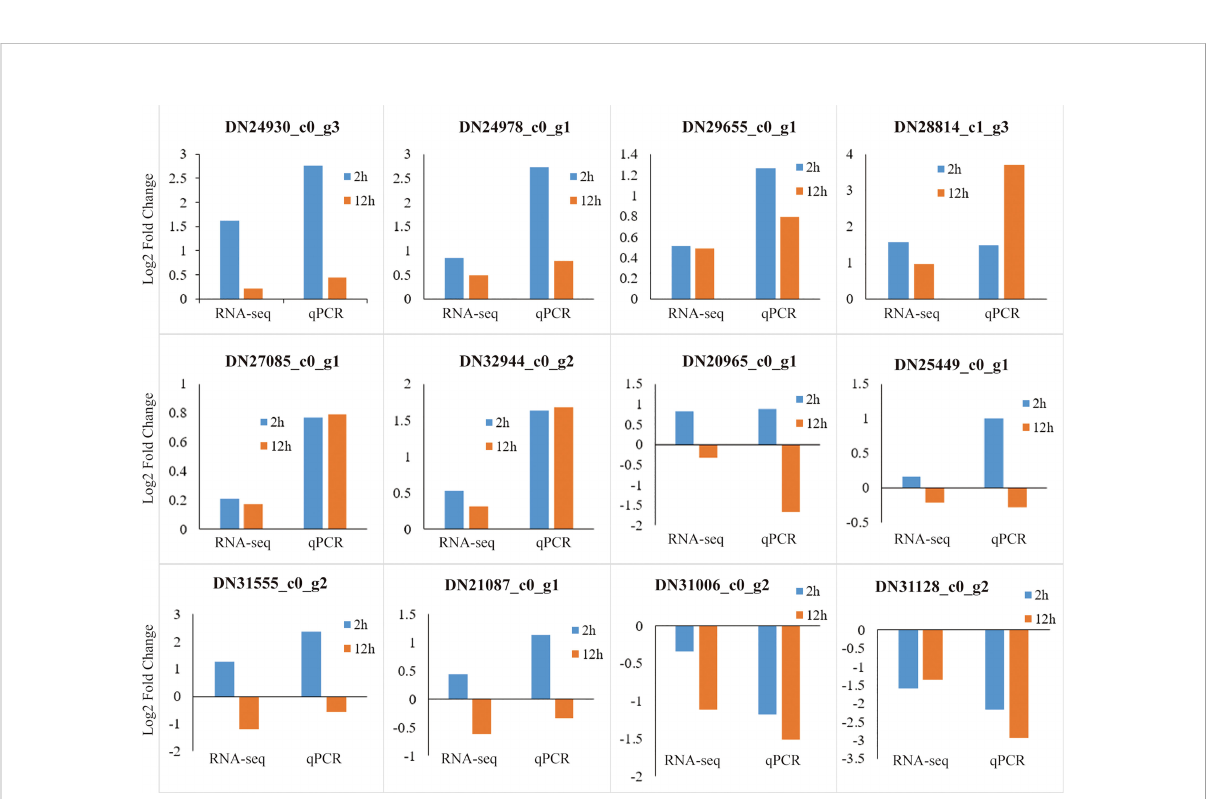
FIGURE 13 Veri fi cation of RNA-seq data through qRT-PCR. The abscissa represents comparison of the DEG expression level at 2 h (blue) and 12 h (red brown) to that at 0 h determined by RNA-seq and qRT-PCR, respectively. The ordinate represents the Log2 Fold Change values of the